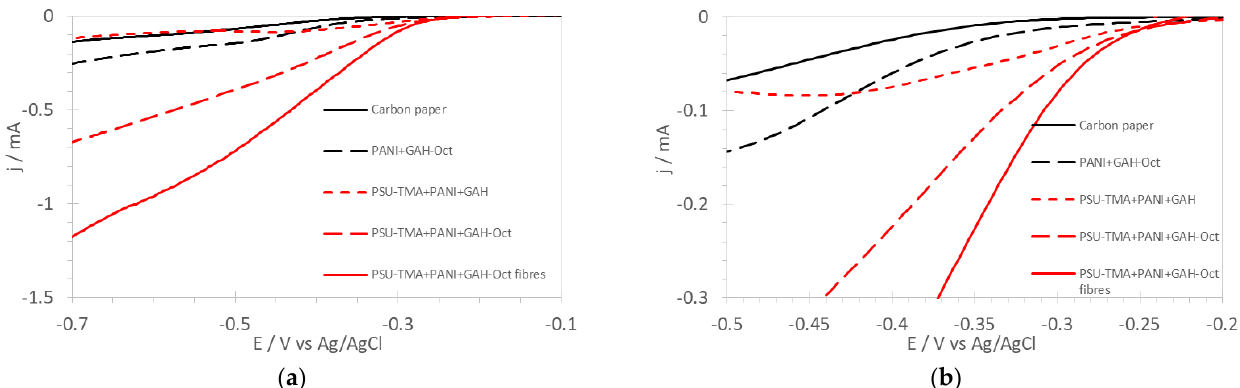
Figure 6. ( a ) Linear sweep voltammograms of the ORR in O 2 -saturated 1 M KOH with RDE at 1500 rpm for various electrodes. ( b ) Focus on the low current region. A comparison of LSV of PSU-TMA + PANI + GAH-Oct electrodes with commercial Pt/C foil is shown in Figure 7.